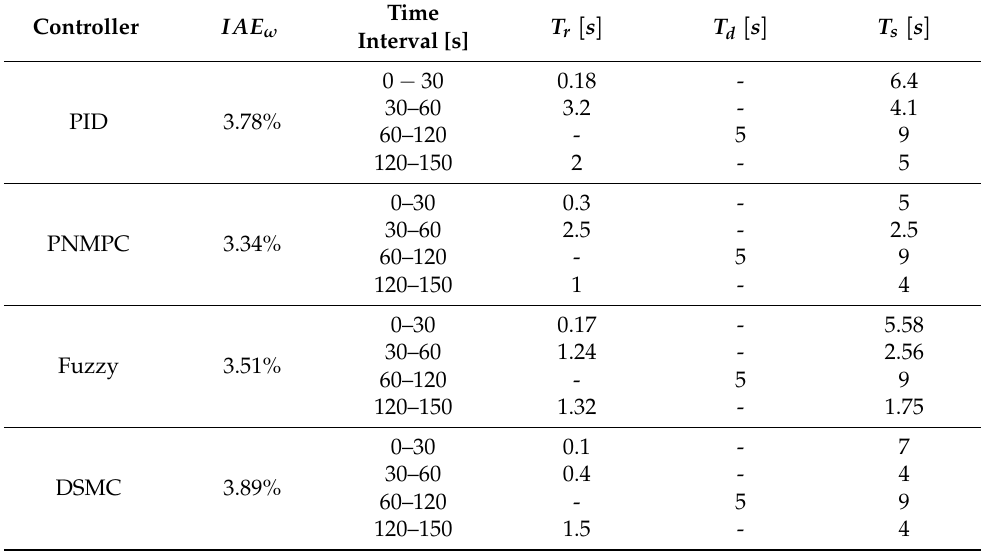
Table 8. System response with application of the reference signal with amplitude variation.